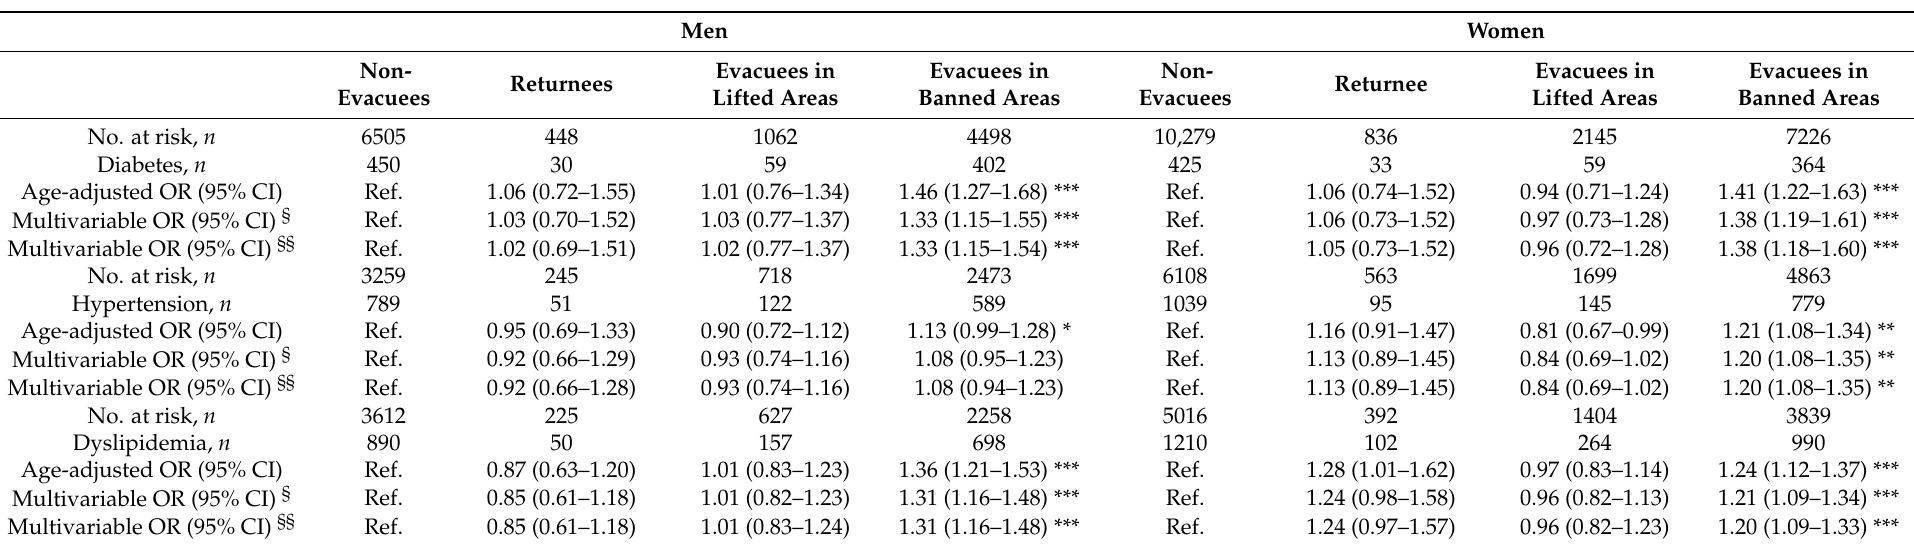
Table 3. Gender-specific age-adjusted and multivariable odds ratios of diabetes, hypertension, and dyslipidemia according to evacuation status. Men